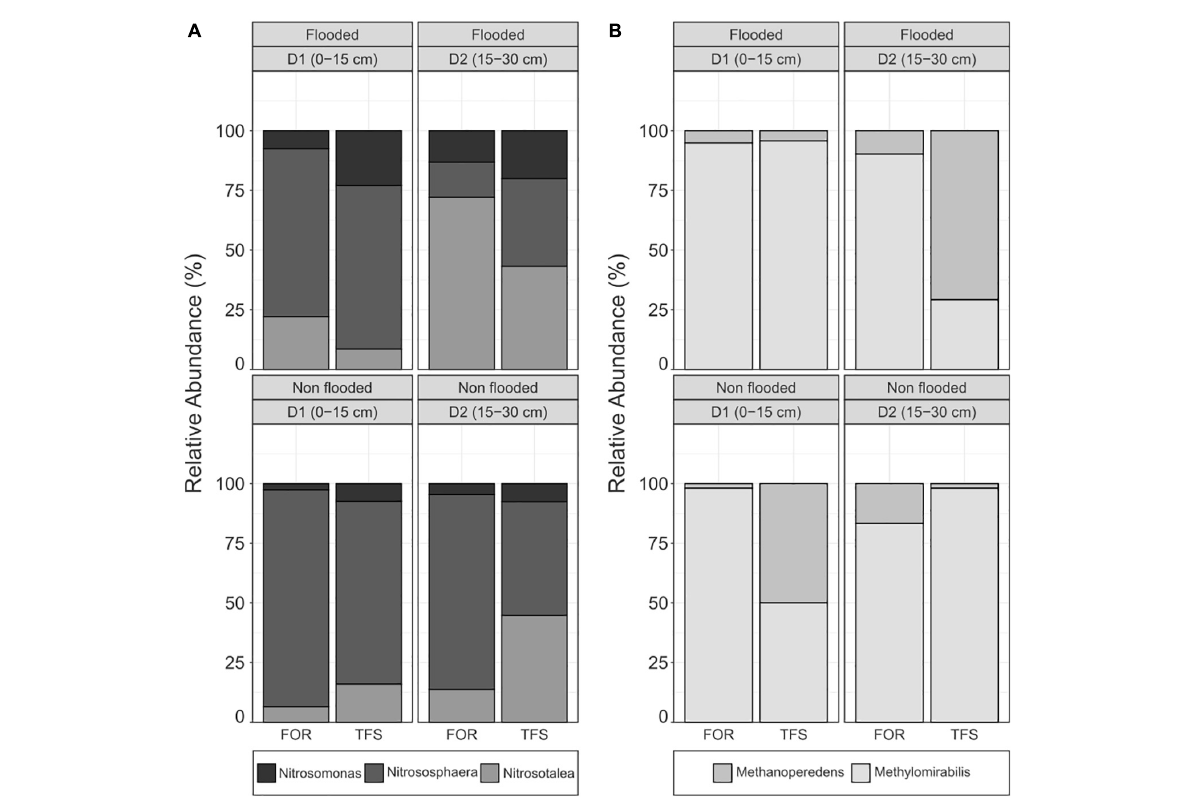
FIGURE2 Relative abundance of (A) active ammonia-oxidizing genera and (B) active nitrogen-dependent anaerobic methane-oxidizing genera in each depth (0–15 and 15–30 cm), and season [Non-flood (NF) and Flood (F)], for contrasting land uses [Agroforest (TFS) and Forest (FOR)] in the Tocantins River